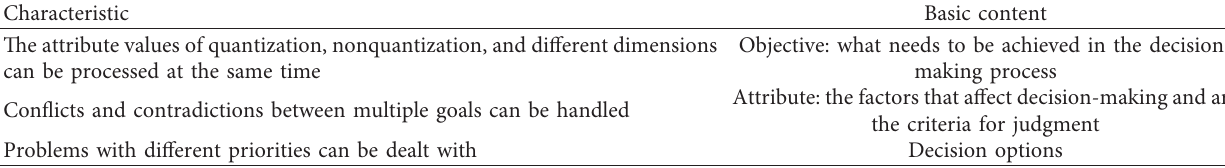
Table 1: The content and characteristics of multicriteria